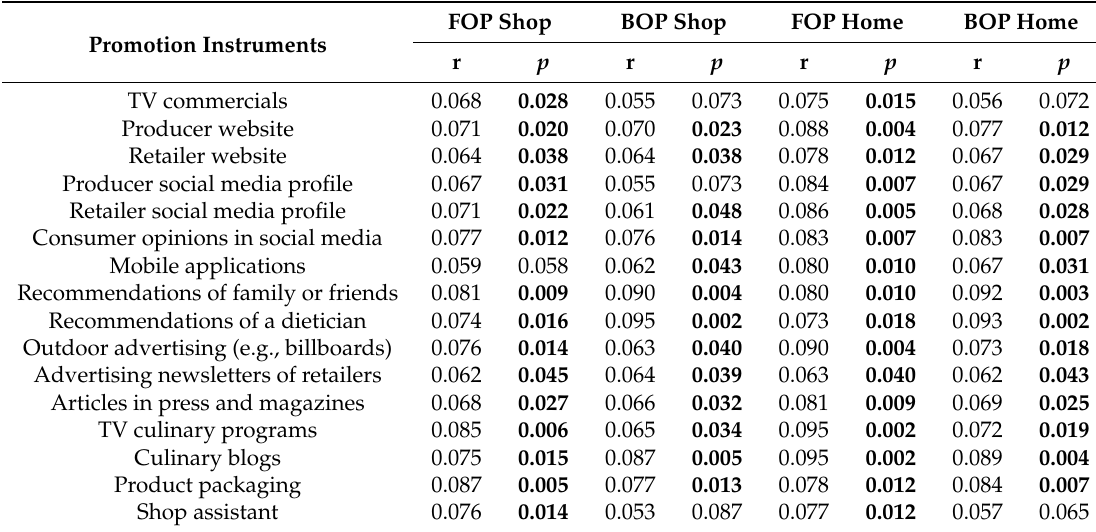
Table 16. Pearson correlation coe ffi cients of reading food labels with the evaluation of the importance of selected promotion instruments for food products with health and nutrition claims.